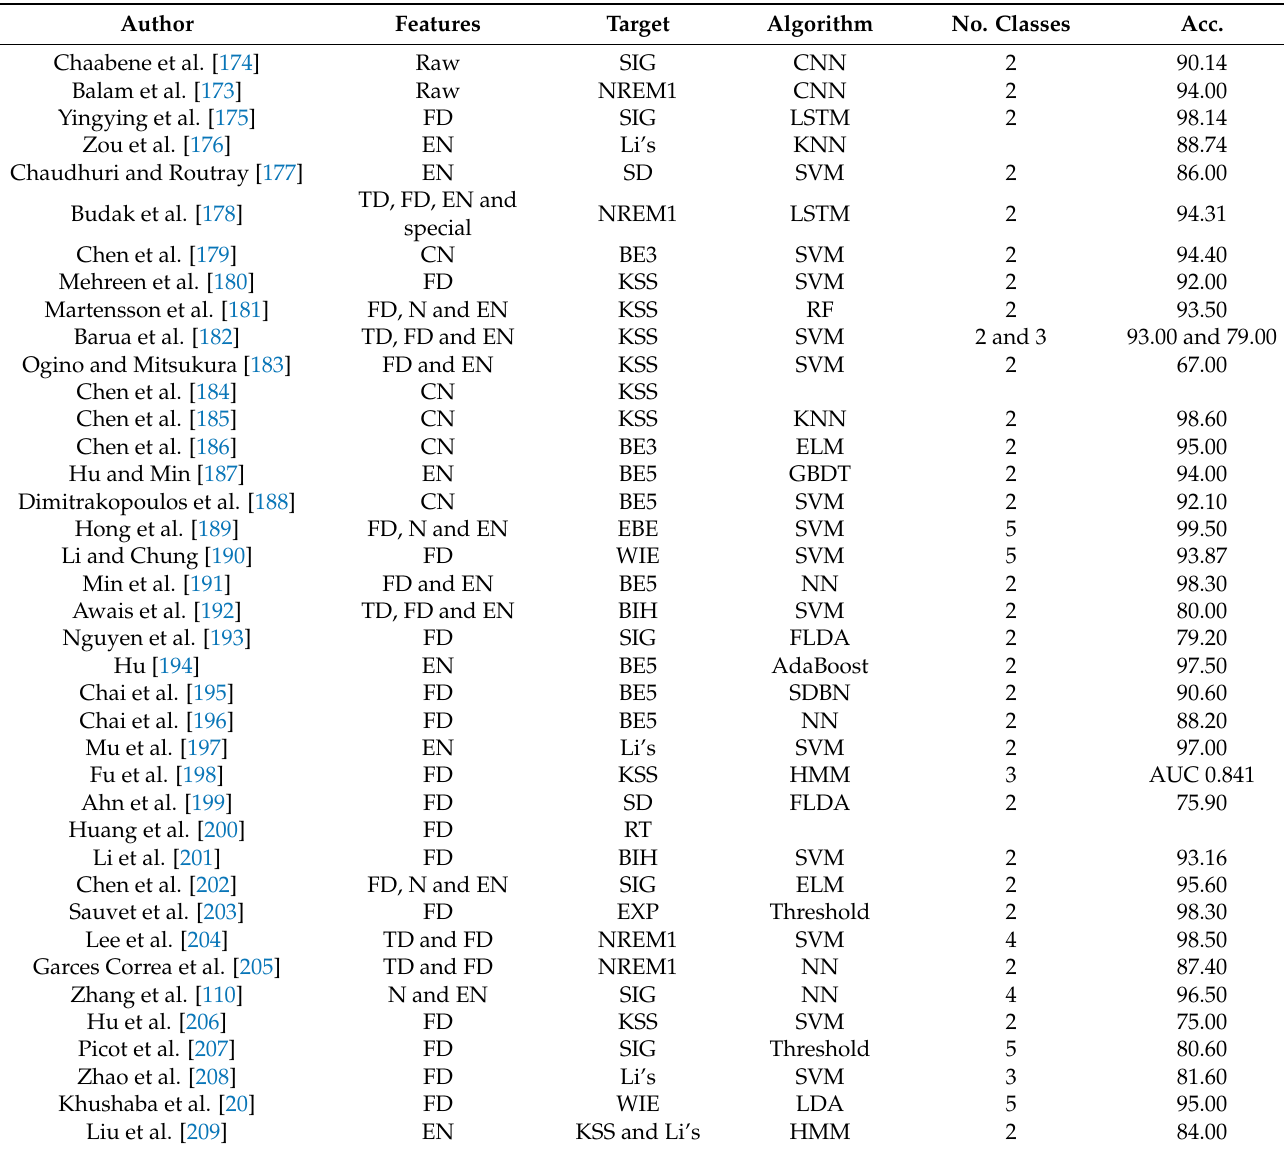
Table 4. The summary of reviewed driver drowsiness detection papers. The meanings of the abbreviations are: TD— time-domain, FD—frequency-domain, N—nonlinear, EN—entropies, CN—complex networks, SIG—signal-based